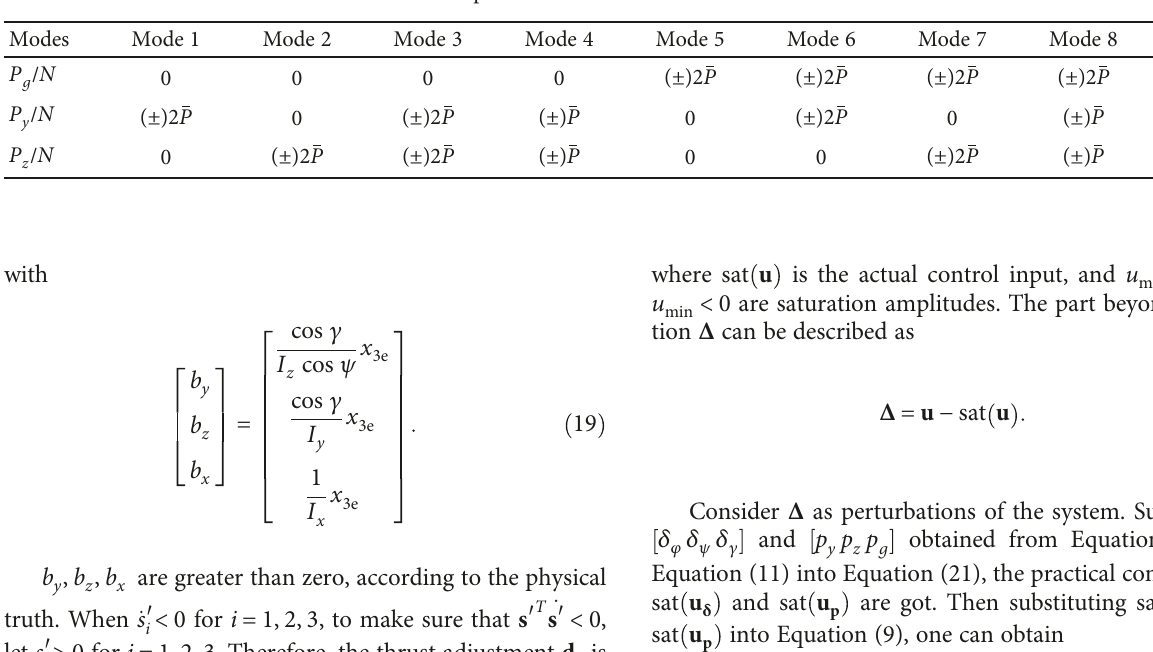
Table 2: The possible control combination of lateral